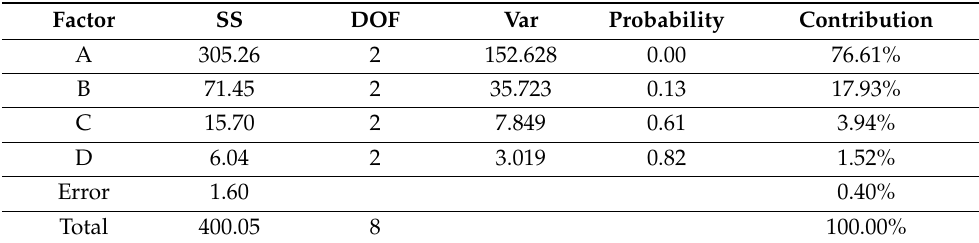
Table 4. ANOVA results at various clog